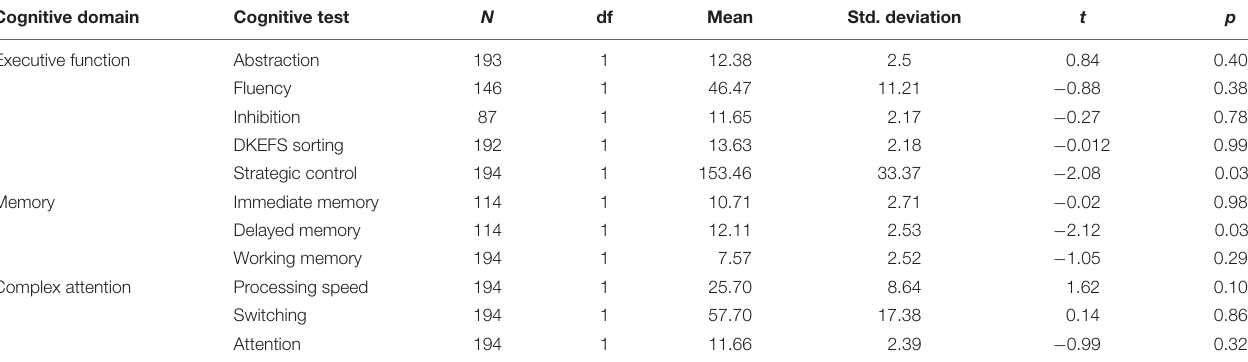
TABLE 4 | Cognitive factors influencing framing